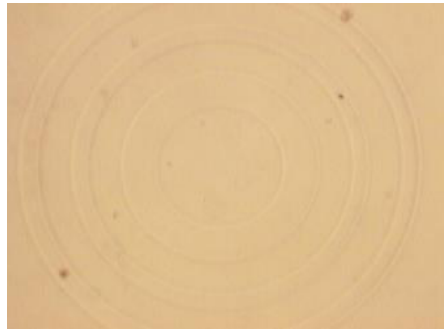
Figure 1. Image of an interference based EDOF design. The diameter of the external circle is about 3